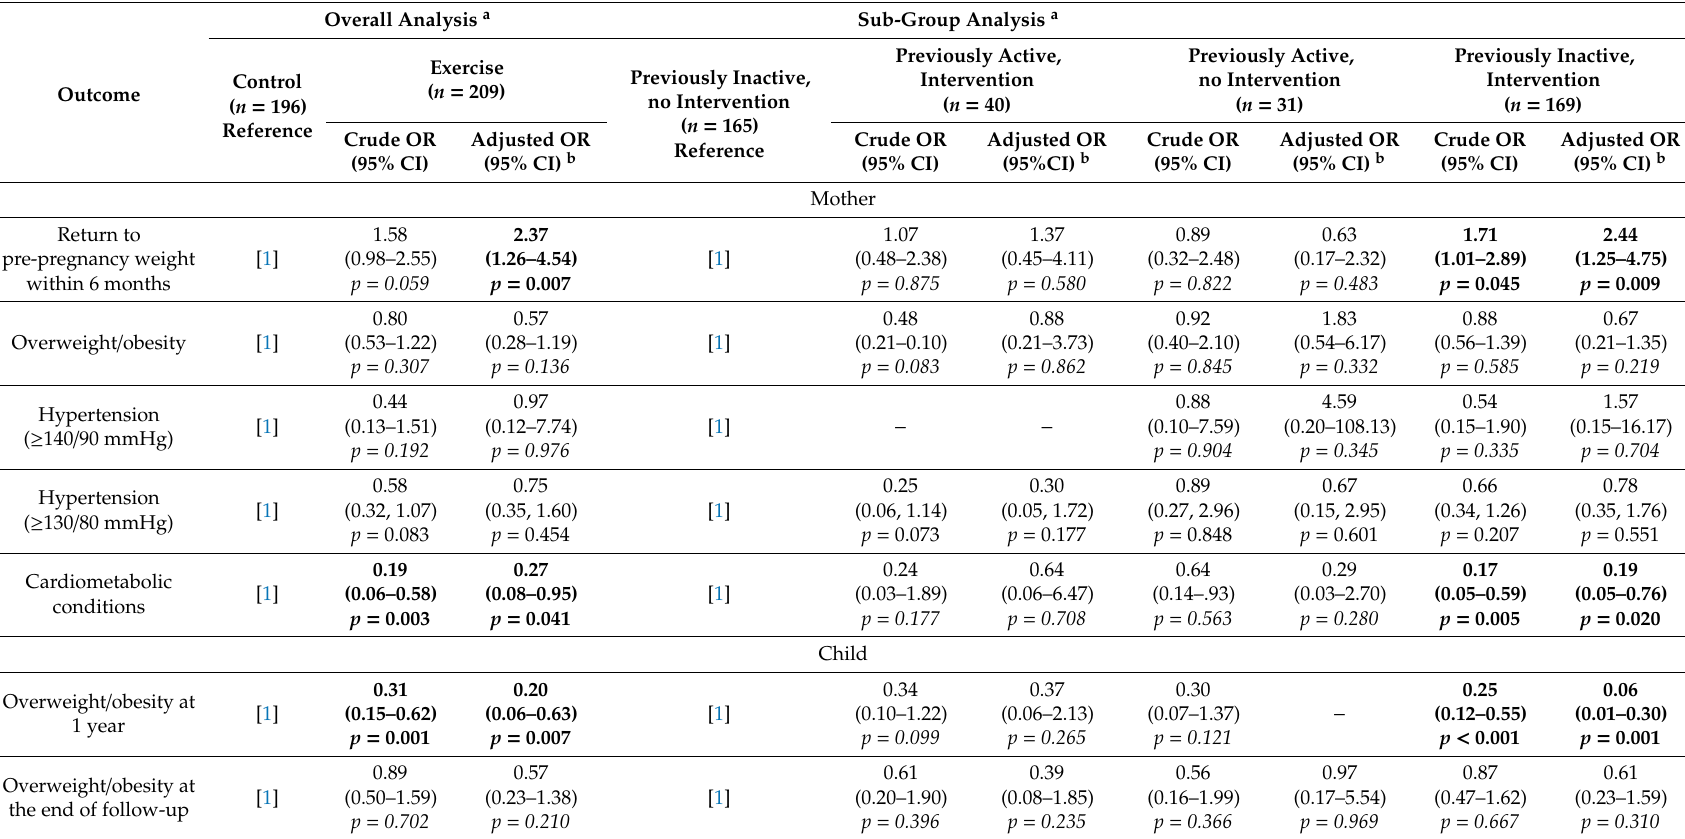
Table 4. Association of pre-pregnancy and pregnancy exercise with study outcomes at post-natal